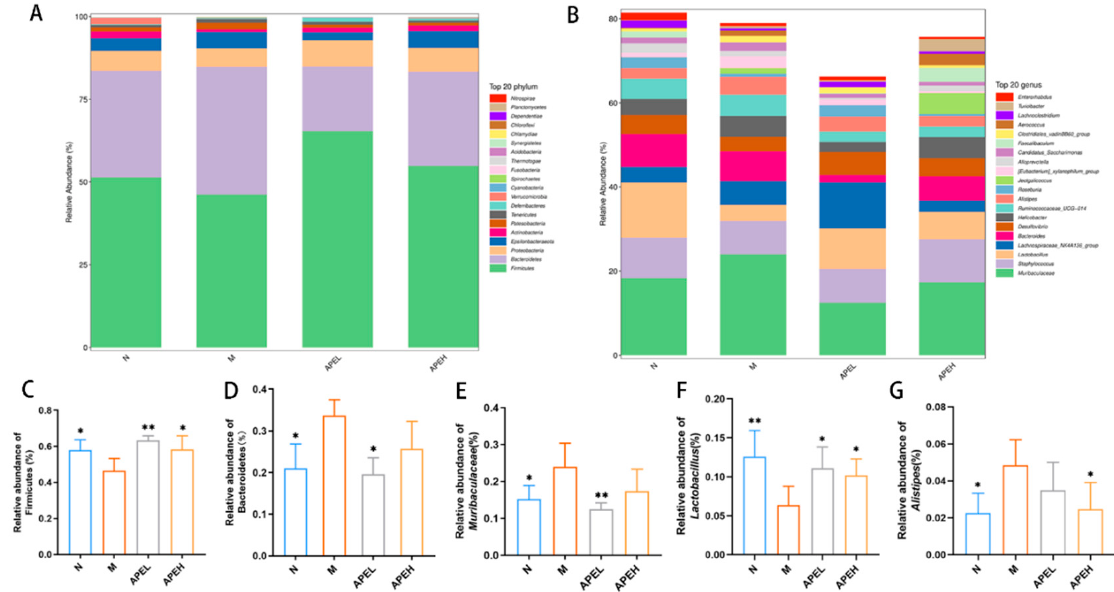
Figure 5. Relative abundance plots displaying the differences in the microbial community structure at the phylum level (top 20) ( A ) and genus level (top 20) ( B ); relative abundance of Firmicutes ( C ), Bacteroidetes ( D ), Muribaculaceae ( E ), Lactobacillus ( F ), and Alistipes ( G ). ((*) p < 0.05 and (**) p < 0.01 compared to the model group). (N, normal group; M, model group; APEL, 150 mg/kg APE group; APEH, 300 mg/kg APE